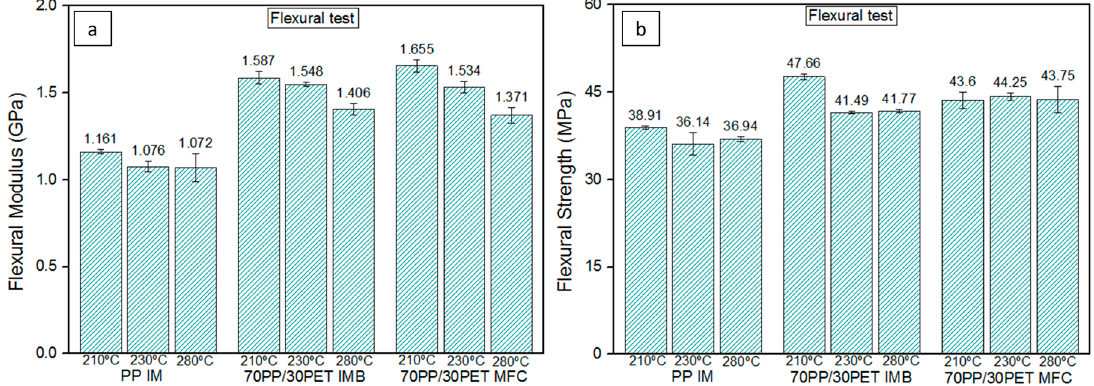
Figure 10. Comparison of flexural properties of PP IM, 70PP/30PET IMBs, and 70PP/30PET MFCs at three different T im ( a ) flexural modulus; ( b ) flexural strength.